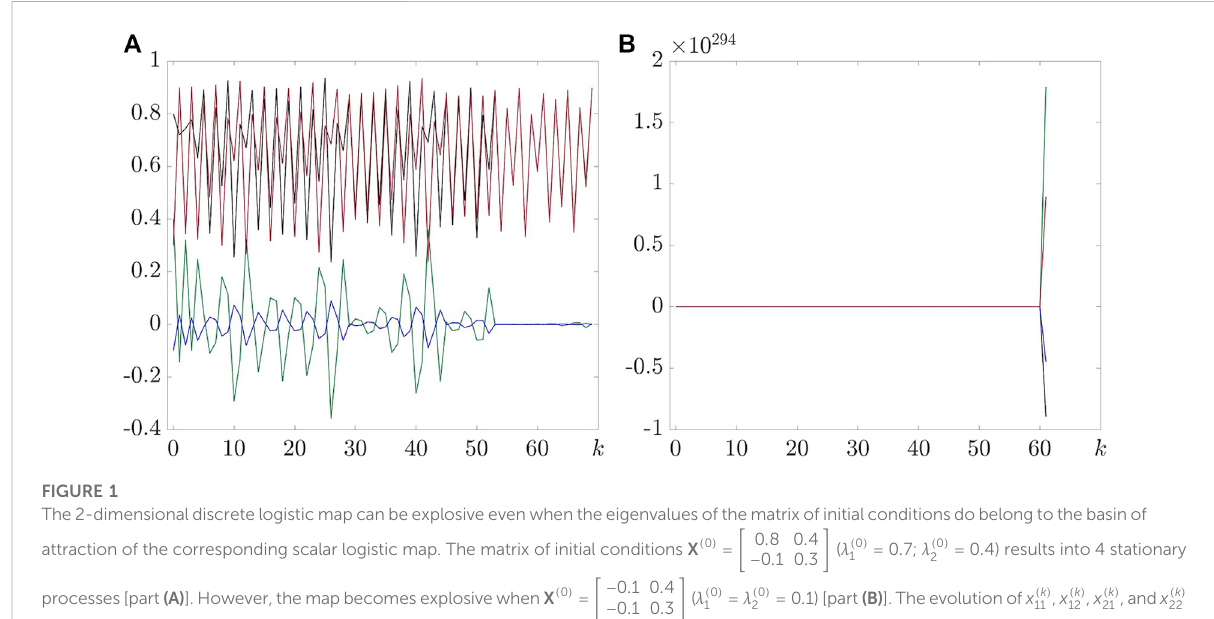
0 . 8 0 . 4 (cid:2) 0 . 7; λ ( 0 ) (cid:2) 0 . 4) results into 4 stationary (cid:5) (cid:6) ( λ ( 0 ) − 0 . 1 0 . 3 1 2 − 0 . 1 0 . 4 (cid:2) λ ( 0 ) (cid:2) 0 . 1)[part (B) ].Theevolutionof x ( k ) x ( k ) x ( k ) x ( k ) (cid:5) (cid:6) ( λ ( 0 ) − 0 . 1 0 . 3 1 11 , 2 12 , 21 ,and 22